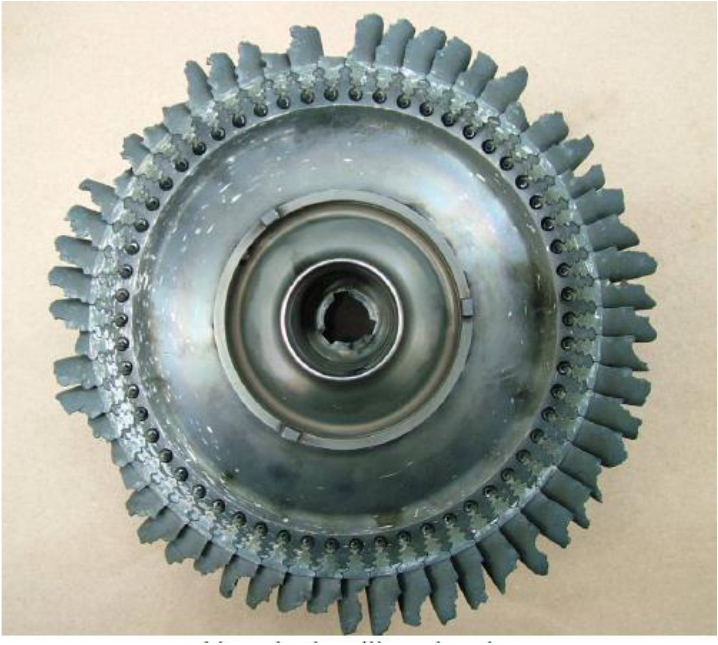
Figure 5. The extensive damage to the turbine by the catastrophic fatigue failure of one blade during a flight [39].